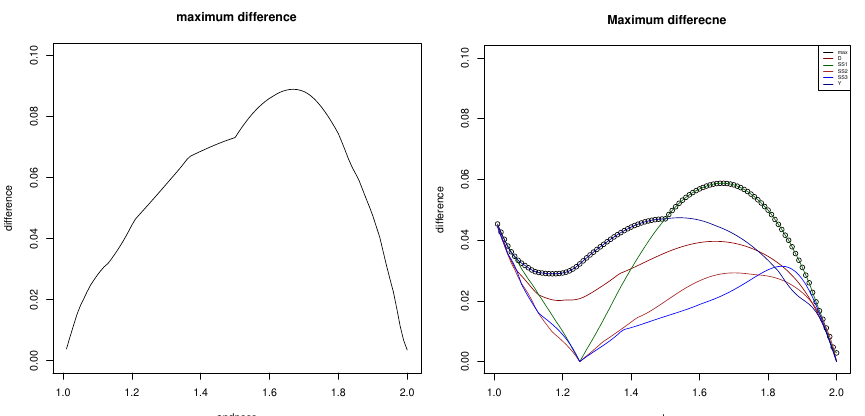
Figure 3. Given andness α , maximum difference between pairs of t-norms T D , T SS 1 , T SS 2 , T SS 3 , T Y ( left ), and difference between high hyperconjunction hC and the same t-norms ( right ). The parameters of the t-norms ( λ , p , or w ) have been selected so that the t-norm has precisely andness α (i.e., ( λ = λ ( α ) , p = p ( α ) , and w = w ( α )